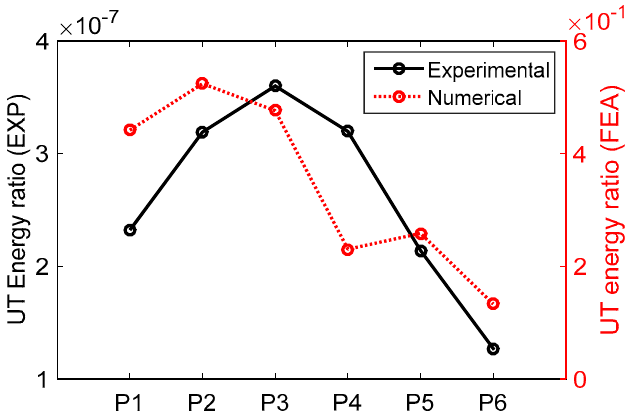
Figure 10. The comparison of numerical and experimental UT energy ratios.